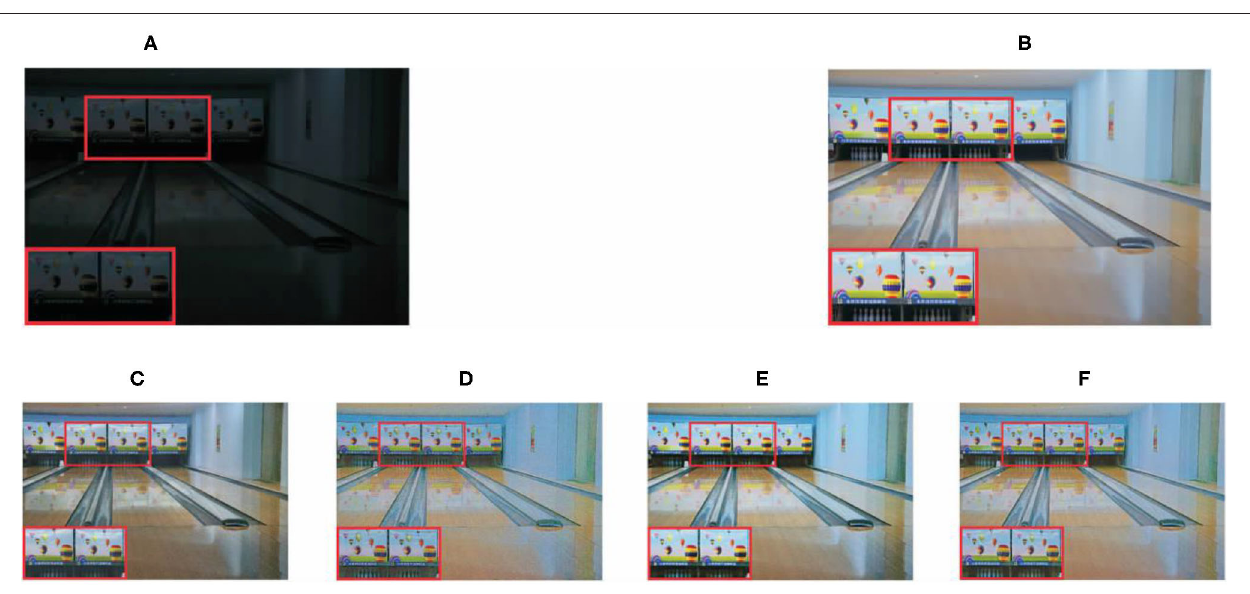
Frontiers in Neurorobotics |